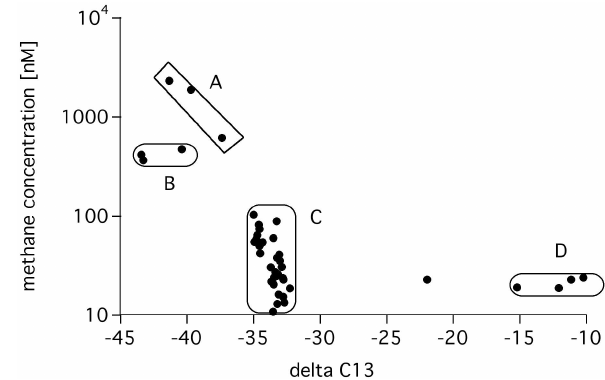
Fig. 6. Carbon isotope signature of methane in 2010, with corre- sponding methane concentrations in meltwater (A) , Olenekskaya Channel (B) , Buor-Khaya Bay (C) and two separate stations in Buor-Khaya Bay (D) , indicated with an asterisk in Fig.